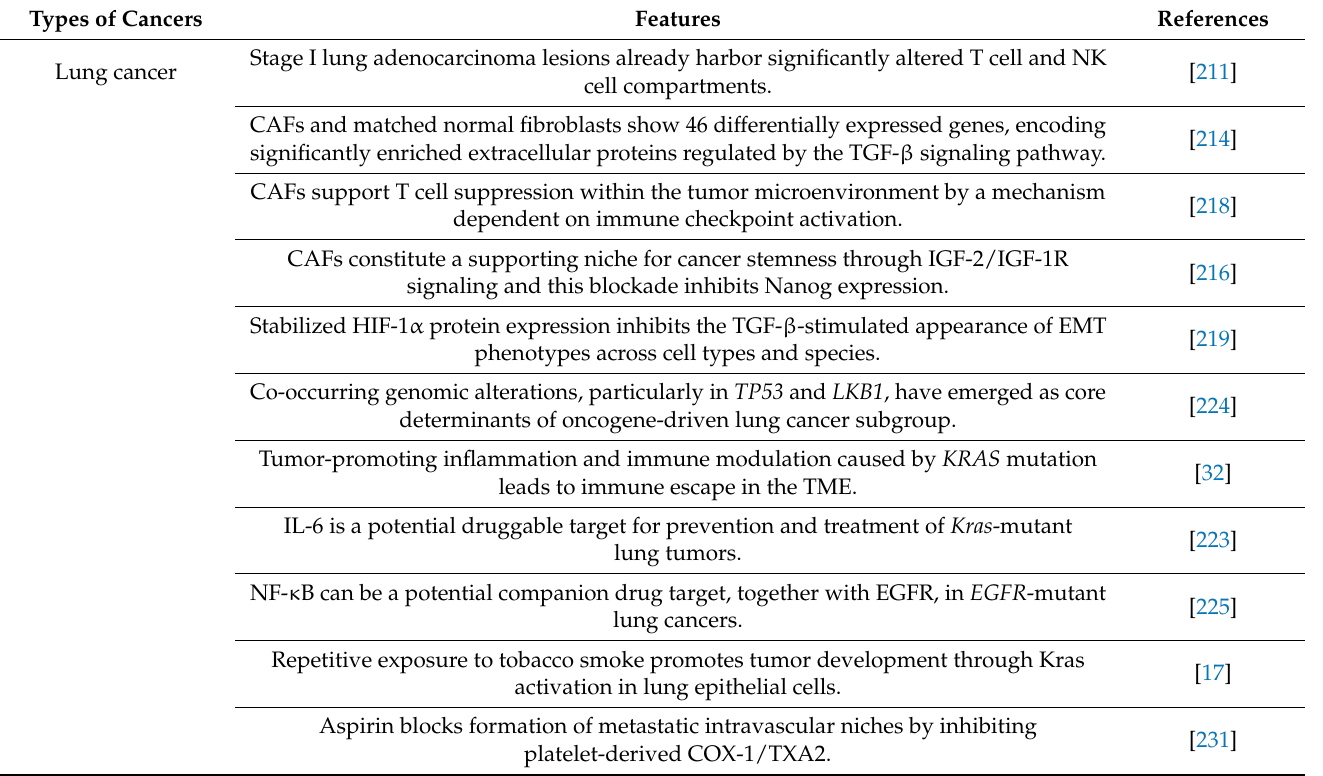
Table 2. Role of inflammation in lung, prostate, and breast cancers and hematological malignancies. Types of Cancers Lung